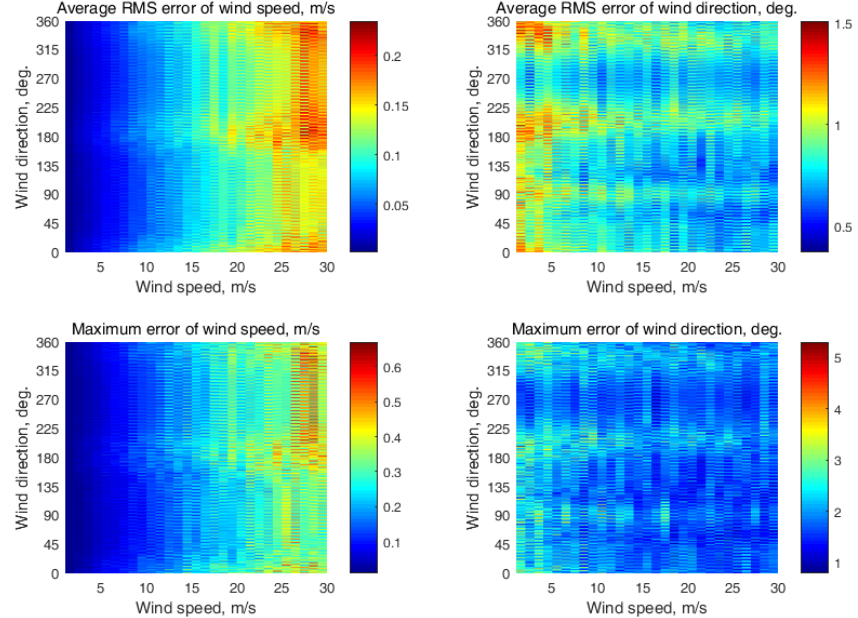
Figure A5. Semicircular wind retrieval results at a single 45° incidence angle.